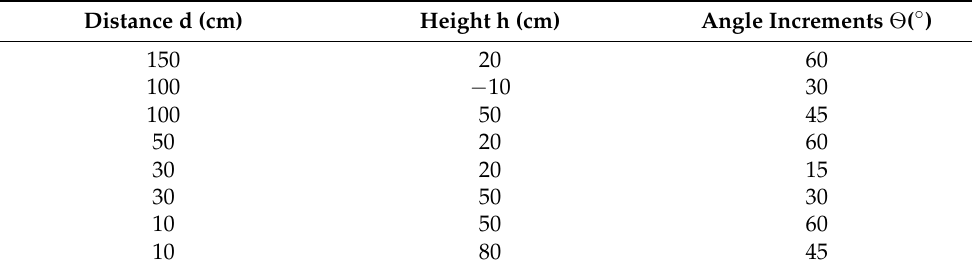
Figure 4. Comparison of the two most fit gene sets from each generations; volume and surface area to control values, including linear approximation of trend in number of photos. The camera position cylindrical coordinates for the final gene are shown in Table 4: Table 4. Final camera positions for most fit gene series